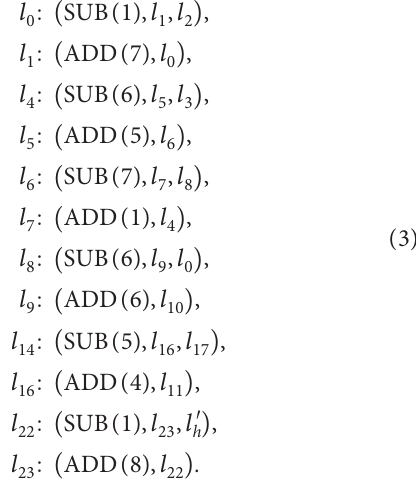
) , l , l ) and ADD instruction l j k 1